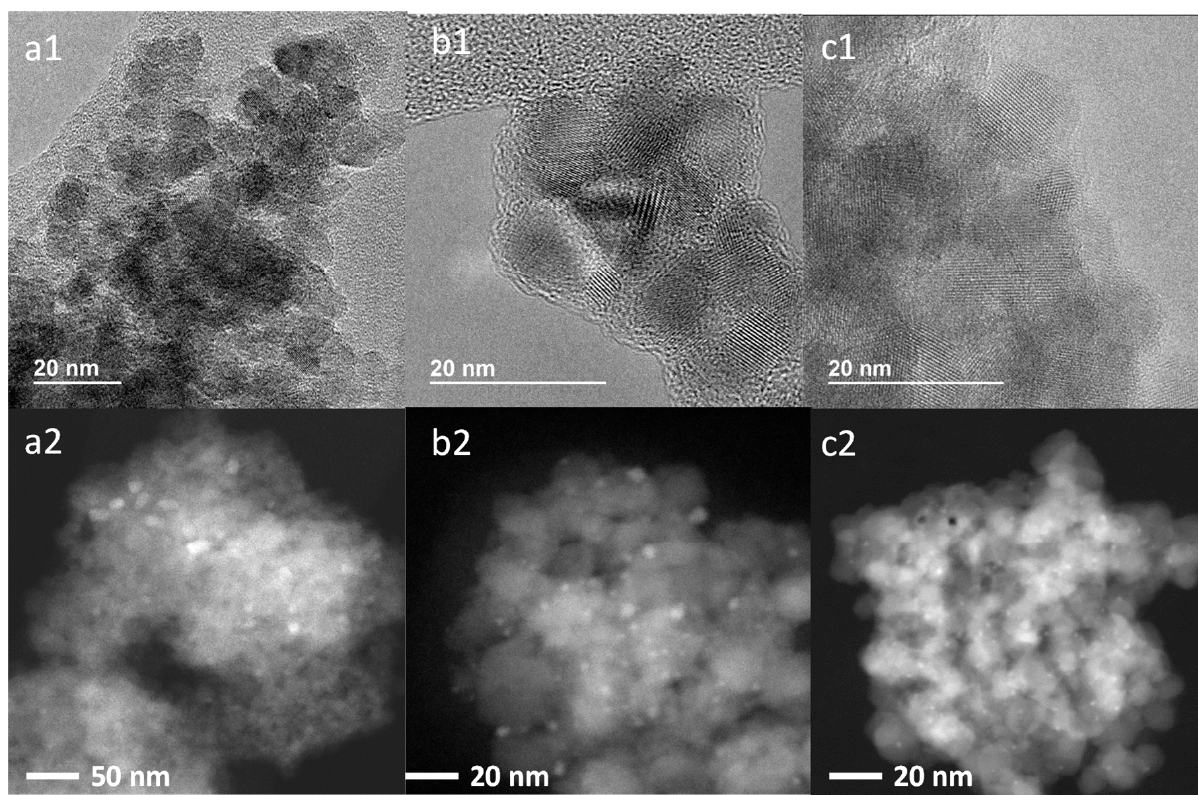
Figure 9. HR-TEM (1) and HR-STEM (2) images of ( a ) fresh, ( b ) reused and ( c ) regenerated (with H 2 ) Pd/TiO 2 nano catalyst. The X-ray diffractions patterns after first and fourth uses of the Pd/TiO 2 nano catalyst (Figure 10) showed practically identical signals for all the measured catalytic samples, with only a small shift in the peak placed at 2 θ = 40 ◦ assigned to Pd(111), probably due to the transformation of Pd 0 into Pd 2+ species. This indicates that the structure of the catalyst remained practically unaltered and just a few changes in the Pd species state take place during the hydrotreatment